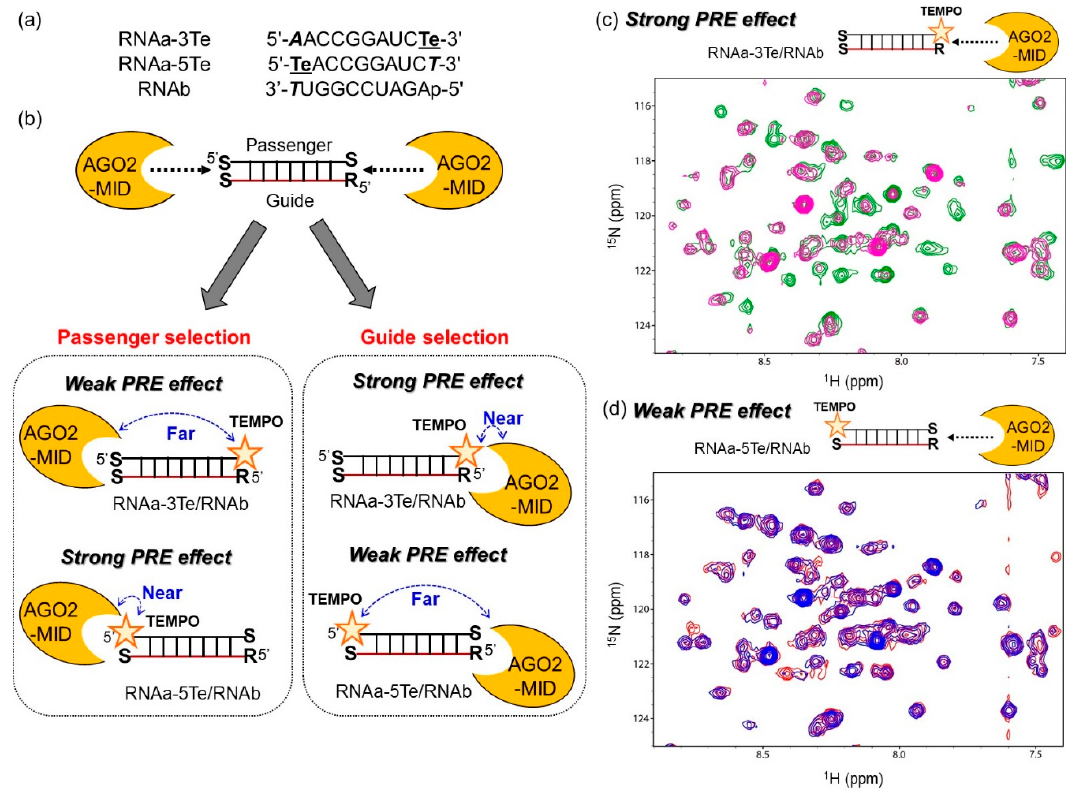
Figure 5. ( a ) RNAs used in the nuclear magnetic resonance (NMR) analyses. Te indicates TEMPO incorporated using a D-threoninol backbone. Bold, italic characters indicate SNA and p denotes the 5’-phosphate group. ( b ) Schematic illustration of the NMR analyses for investigation of strand selection by AGO2-MID. (c and d) 1 H- 15 N heteronuclear single-quantum coherence (HSQC) NMR spectra of AGO2-MID (0.06 mM) with ( c ) RNAa-5Te / RNAb (0.4 mM) or (d) RNAa-3Te / RNAb (0.4 mM) in the absence (magenta or blue) and presence (green or red) of 2 mM ascorbic acid.